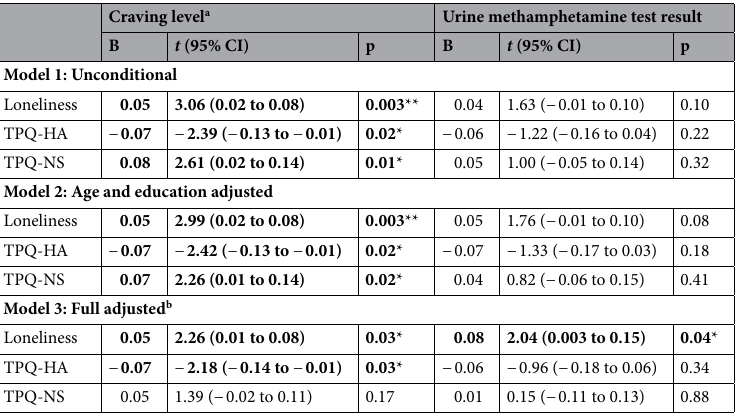
Table 3. Association between baseline loneliness, personality traits, craving level for methamphetamine, and urinary methamphetamine test results during the 1-year treatment program in methamphetamine-use patients. *p < 0.05, **p < 0.01. TPQ tridimensional personality questionnaire, HA harm avoidance, NS novelty seeking. a Transformed VAS by log (x + 1). b Model 3: adjusting for age, education, disease duration (years), psychiatric comorbidities, measure of support function (MSF), Hamilton depression rating scale (HDRS), family adaptation, partnership, growth, affection, and resolve index (family APGAR), and the numbers of